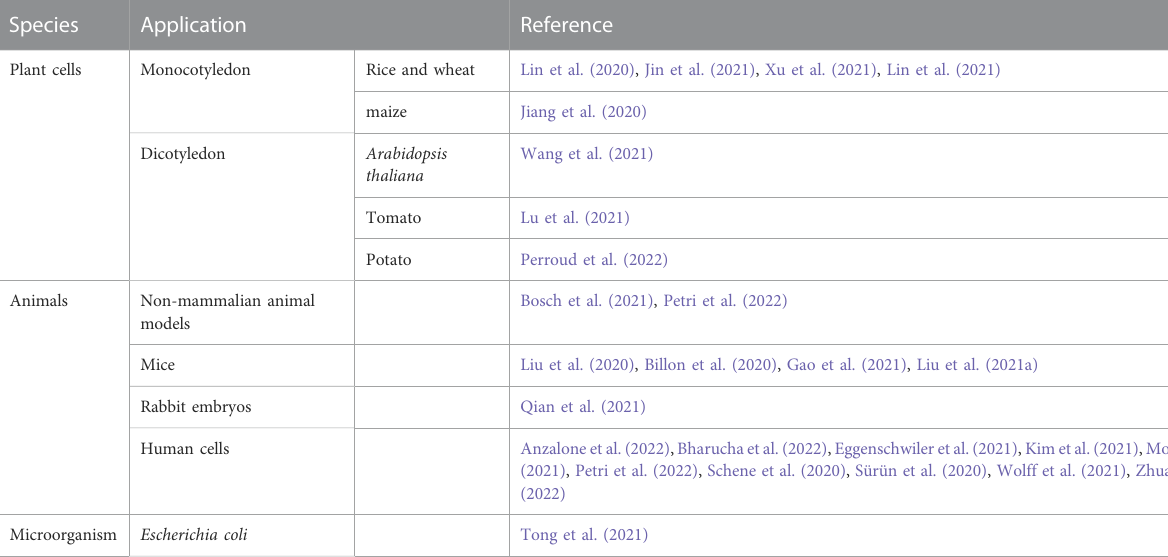
TABLE 1 Application of PE in different species.